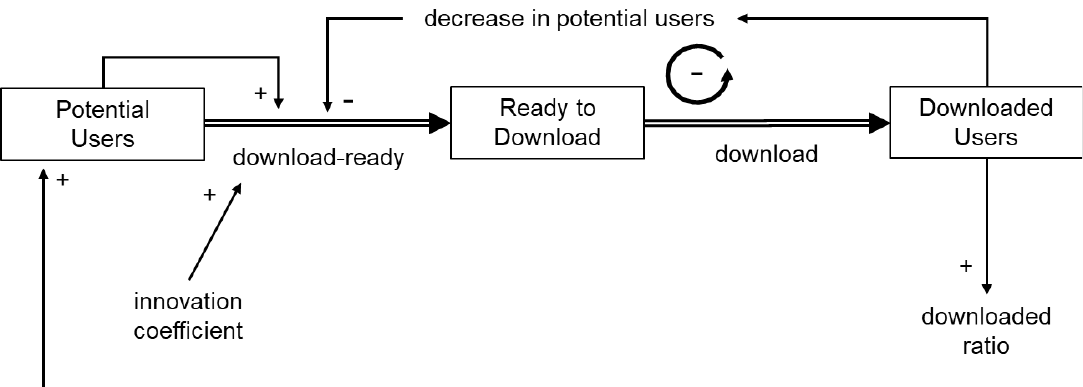
Int. J. Environ. Res. Public Health 2022 , 19 , x FOR PEER REVIEW 9 of 16 Figure 4. Confirmed downloads of COVIDSafe and COCOA apps after release.